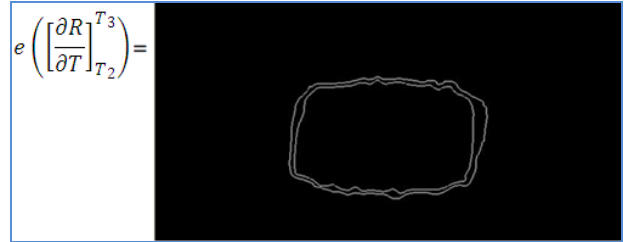
Figure 16. Temperature affected area at the yellow alarm